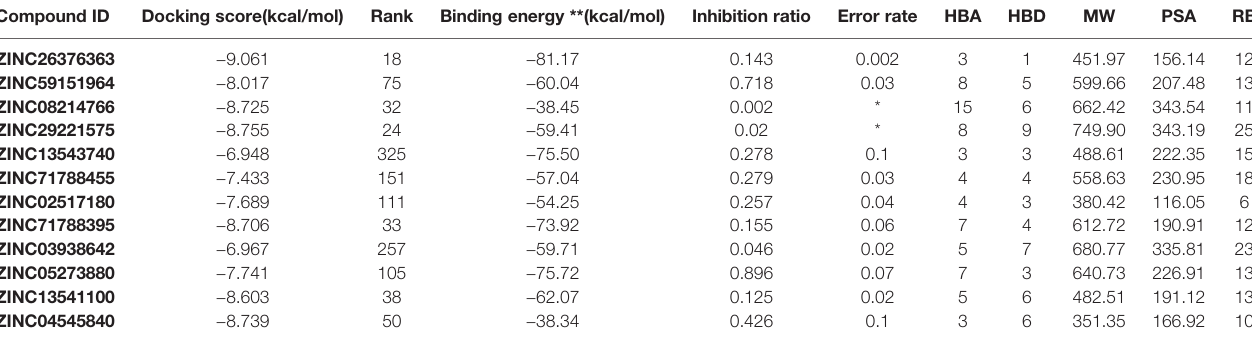
TABLE 1 | Physicochemical and computational properties of experimentally validated compounds. Compound